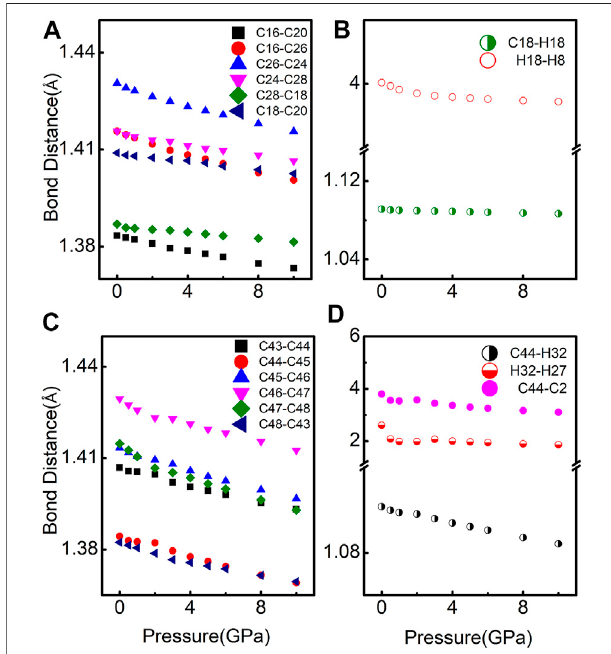
FIGURE 9 | (A, C) Intramolecular C-C distances; (B, D) intermolecular bond distances of phenanthrene under different pressures at phases I and